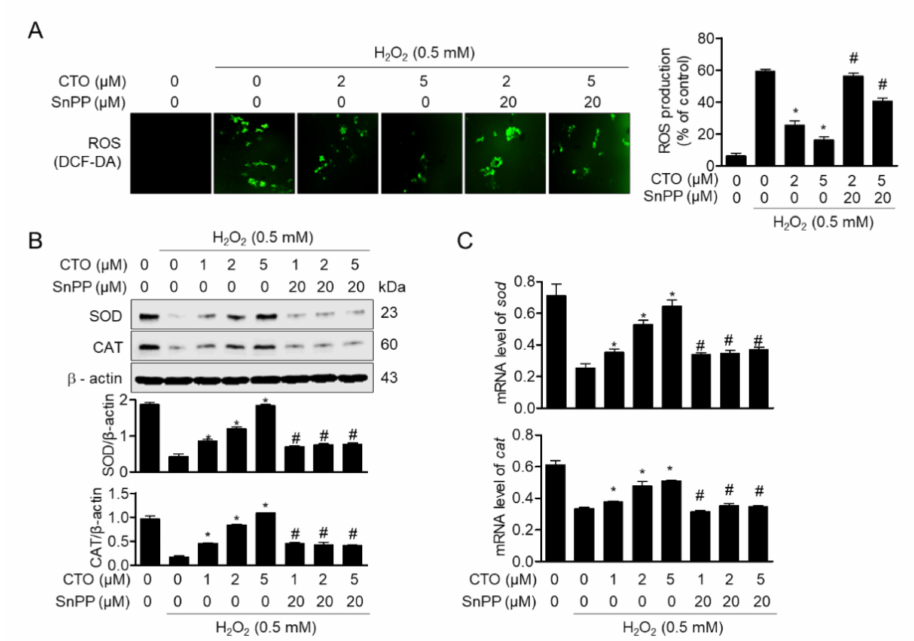
Figure 6. Upregulated HO-1 by pre-treatment with CTO protects SW1353 cells from ROS production induced by H 2 O 2 . ( A ) SW1353 cells were seeded at a density of 5 × 10 4 cell / well and pre-treated with or without 20 µ M Protoporphyrin IX (SnPP) for 1 h. Then cells were treated with the indicated concentrations of CTO (0, 1, 2, and 5 µ M) for 6h, and incubated with 0.5 mM of H 2 O 2 for 2h. The cells were incubated with culture medium containing 20 µ M DCF-DA to monitor ROS production at 37 ◦ C in the dark for 20 min. The images were obtained by fluorescent microscope system. ( B , C ) Protein expressions and mRNA levels of sod and cat were detected by Western blot analysis ( B ) and real-time PCR (C) from cells cultured with the indicated conditions. The results were normalized with β –actin ( B ) or gapdh ( C ) expression. * p < 0.05 vs. only H 2 O 2 treat group; # p < 0.05 vs. only CTO treated